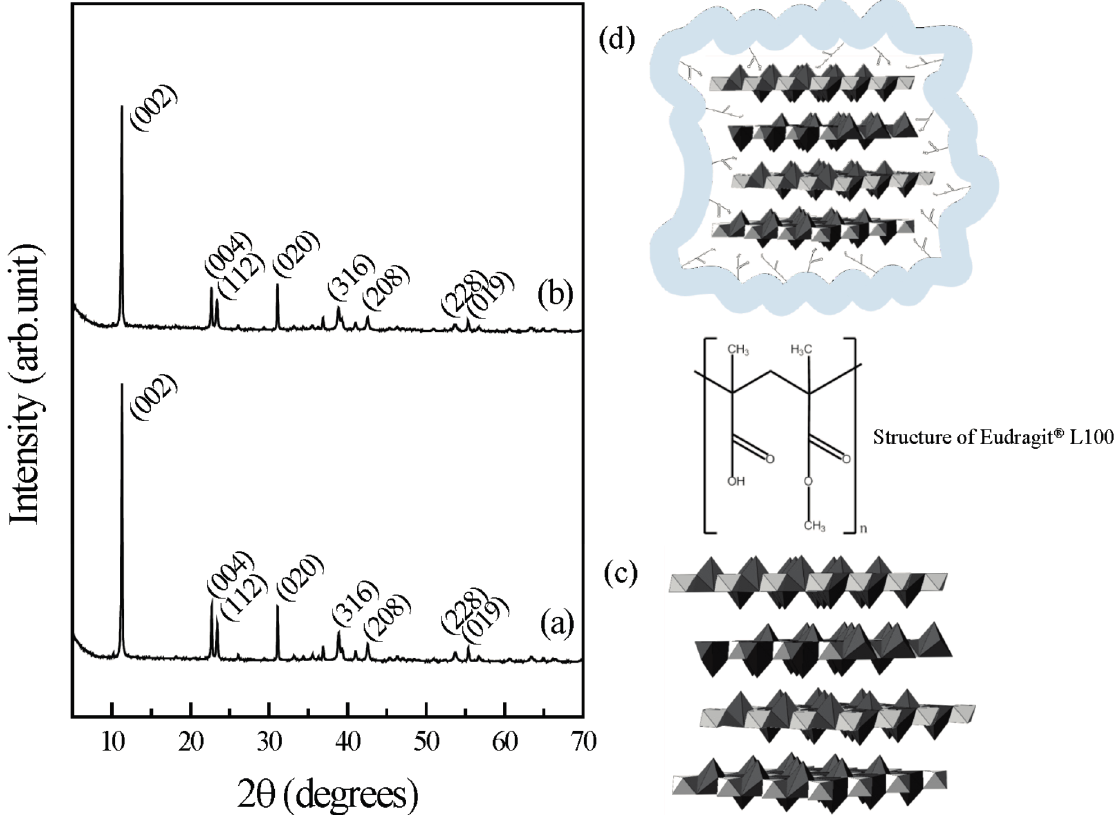
Figure 1. Powder XRD patterns for ( a ) pristine CaAl-LDH and ( b ) E-coated CaAl-LDH; ( c ) Crystal structure of CaAl-LDH (hydrocalumite, JCPDS No. 31-0245) and ( d ) schematic illustration of E-coated